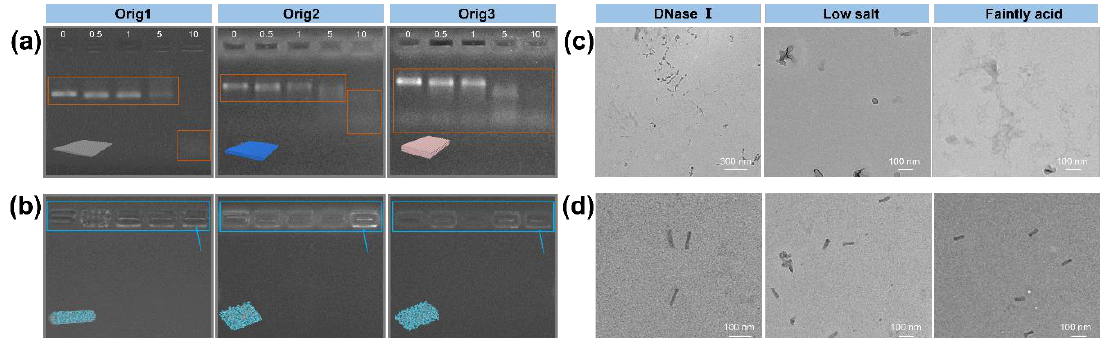
Figure 3. Gel EMSA and TEM test of the stability of DNA origami with and without coating. Gel EMSA of ( a ) plain DNA origami and ( b ) coated origami with nc/no ratio of 1000 treated with DNase I (0, 0.5, 1, 5, 10 Unit in 15 μL of sample volume). TEM images of ( c ) plain Orig1 and ( d ) coated Orig1 with nc/no ratio of 4000 after DNase I, low salt concentration, and acid incubation treatment. DNA fragments were highlighted in red pane, cHSA coated origamis-DNase I complexes were highlighted in blue pane.